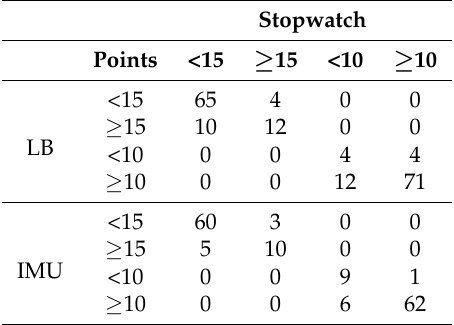
Figure 12. Corresponding Bland–Altman plot. Included levels indicate mean Diff ± 1.96 SD ( − 3.43 to 3.32 s). Table 6. Comparison of the categorization of muscle power in the SST regarding the cut-off values of